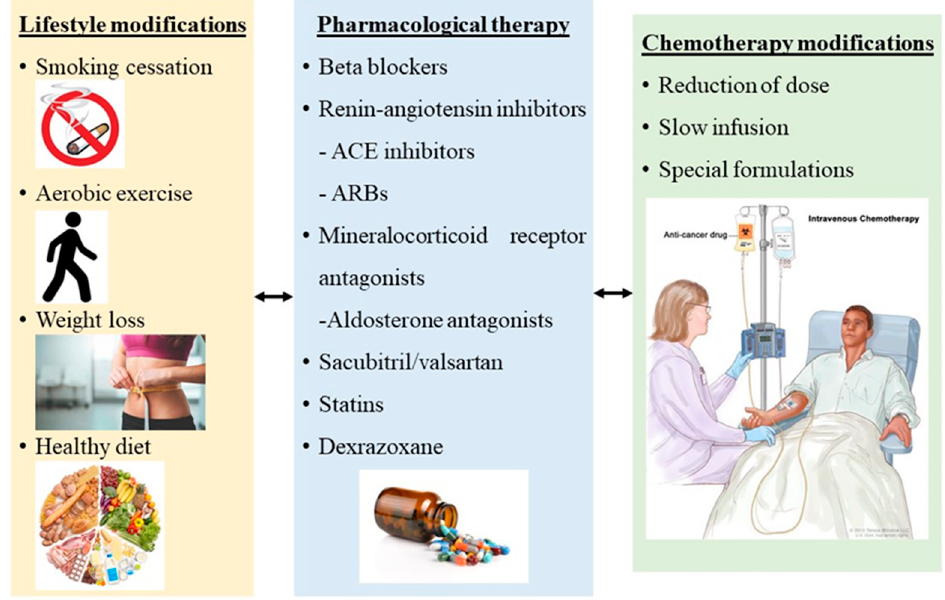
Figure 3. Cardioprotective strategies against chemotherapy cardiotoxicity in cancer patients.